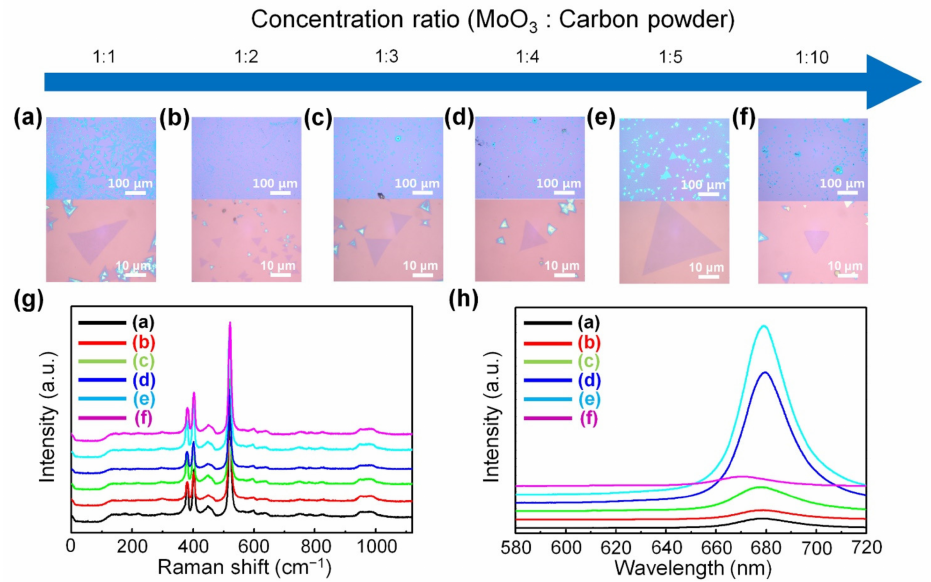
Figure 6. Carbon powder-assisted CVD growth of monolayer MoS 2 . Low-magnification and high- magnification optical images of monolayer MoS 2 synthesized depending on the mixing ratio of carbon powder to MoO 3 powder; ( a ) 1:1, ( b ) 1:2, ( c ) 1:3, ( d ) 1:4, ( e ) 1:5, and ( f ) 1:10, respectively. ( g ) Raman and ( h ) PL spectra of monolayer MoS 2 synthesized using the carbon powder-assisted CVD